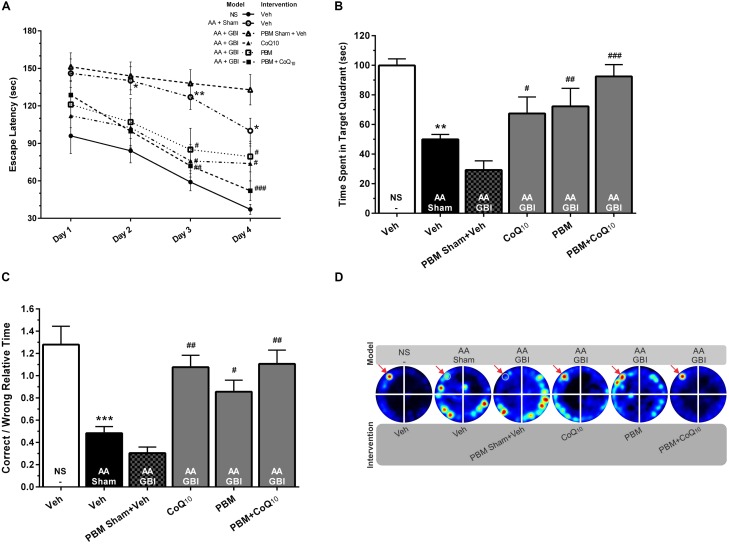
(A) Escape latencies in training sessions in different groups. Differences among groups were analyzed for each day. (B) Time spent in the target quadrant and (C) relative error time in probe sessions in different groups. (D) Corresponding heat maps display the combined traces of the mice from experimental groups during the probe session. Values represent the mean ± SEM, (n = 15). ∗p < 0.05, ∗∗p < 0.01, and ∗∗∗p < 0.001 compared with the NS (control). #p < 0.05, ##p < 0.01, and ###p < 0.001 compared with the AA + GBI. AA, artificially aged; CoQ10, Coenzyme Q10; GBI, global brain ischemia; NS, normal saline; PBM, photobiomodulation; Veh, Vehicle.